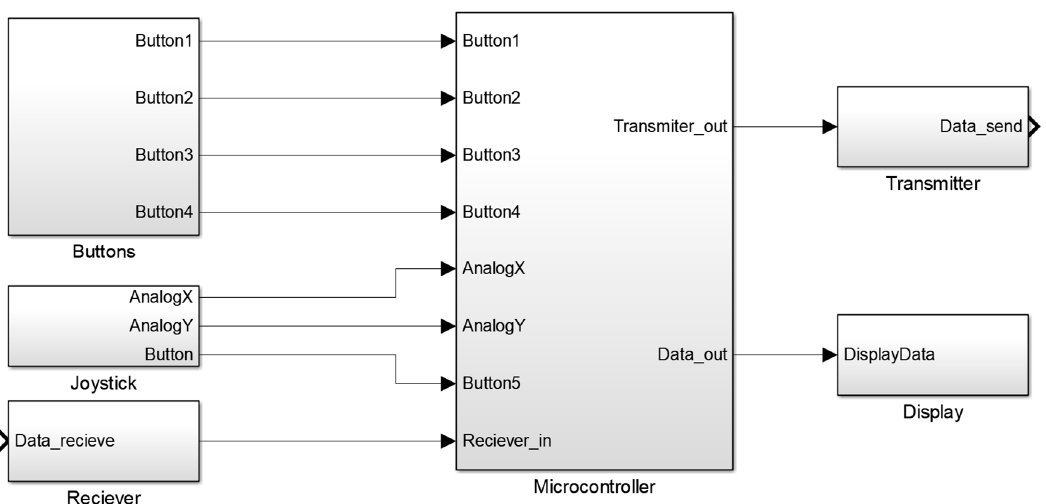
Figure 6. Block scheme of the remote controller.